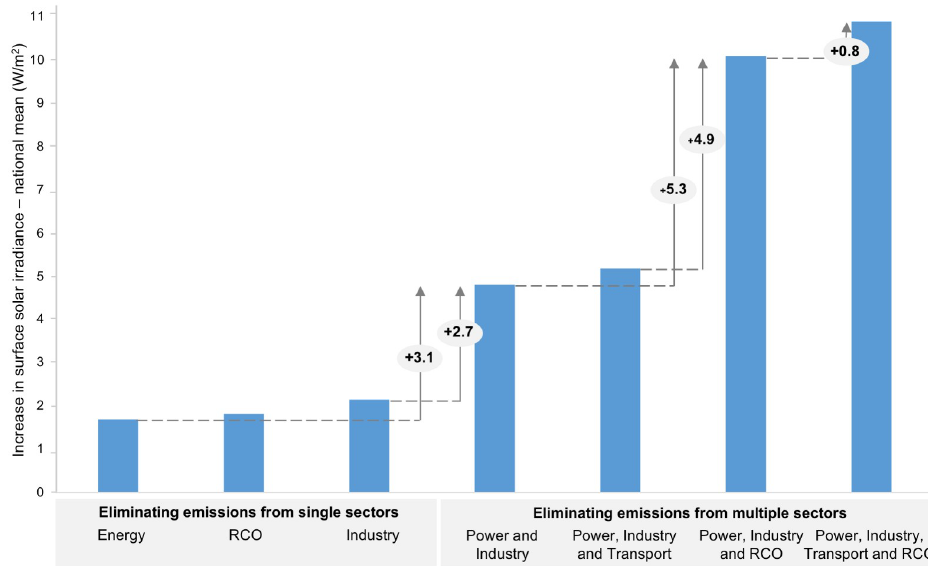
Fig 5. Breakdown of increases in surface solar irradiance (national mean, W/m 2 ). From an elimination of SO 2 , BC, and OC emissions from single sectors: the energy, residential and commercial (RCO) or industrial sectors; and from multiple sectors at the same time: the energy and industrial sectors, both sectors with RCO, and all four sectors together. The national mean is the area-weighted mean increase in surface solar irradiance. The numbers are valid if pollution control happens for the stated single or combined strategies, as the effect is not linear: the relative contribution of each sector is sensitive to the order of pollution measures. Data and material from [19, 24–26].